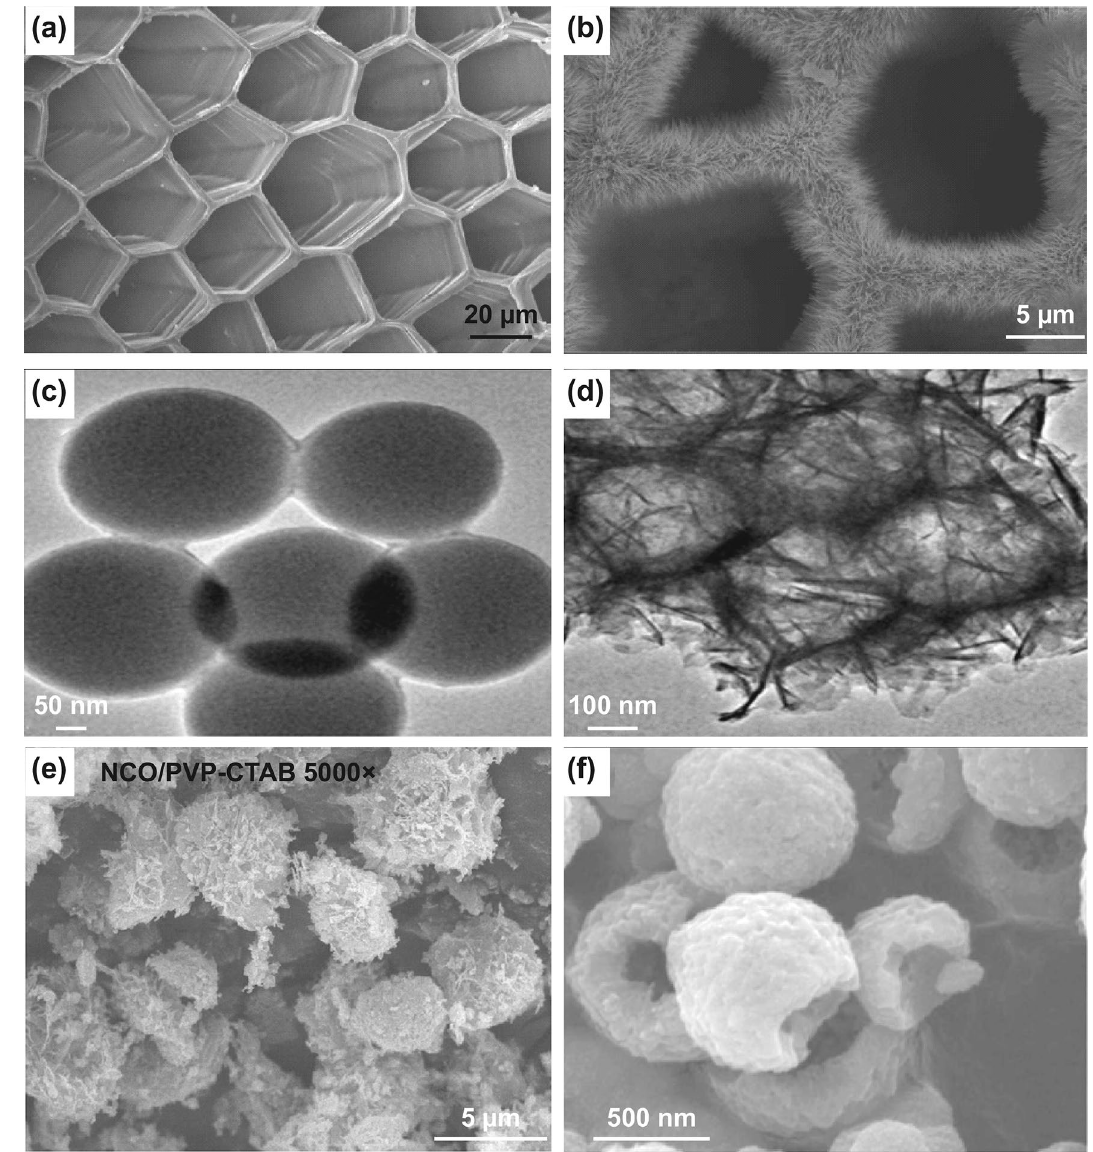
Fig. 11 FESEM images of a MSBPC, b NiCo 2 O 4 nanowires grown on MSBPC. Reproduced with permission from Ref. [129]. Copyright © 2014 American Chemical Society. c TEM image of SiO 2 @RF spheres, d TEM image of NiCo 2 O 4 nanoflakes grown on SiO 2 @RF spheres. Reproduced with permission from Ref. [130]. Copyright © 2018 Elsevier B.V. e FESEM image of micron-sized NiCo 2 O 4 pompon. Reproduced with permission from Ref. [132]. Copyright © 2019 Elsevier B.V. f FESEM image of NiCo 2 O 4 hollow submicron spheres. Reproduced with per- mission from Ref. [133]. Copyright © 2015 Elsevier